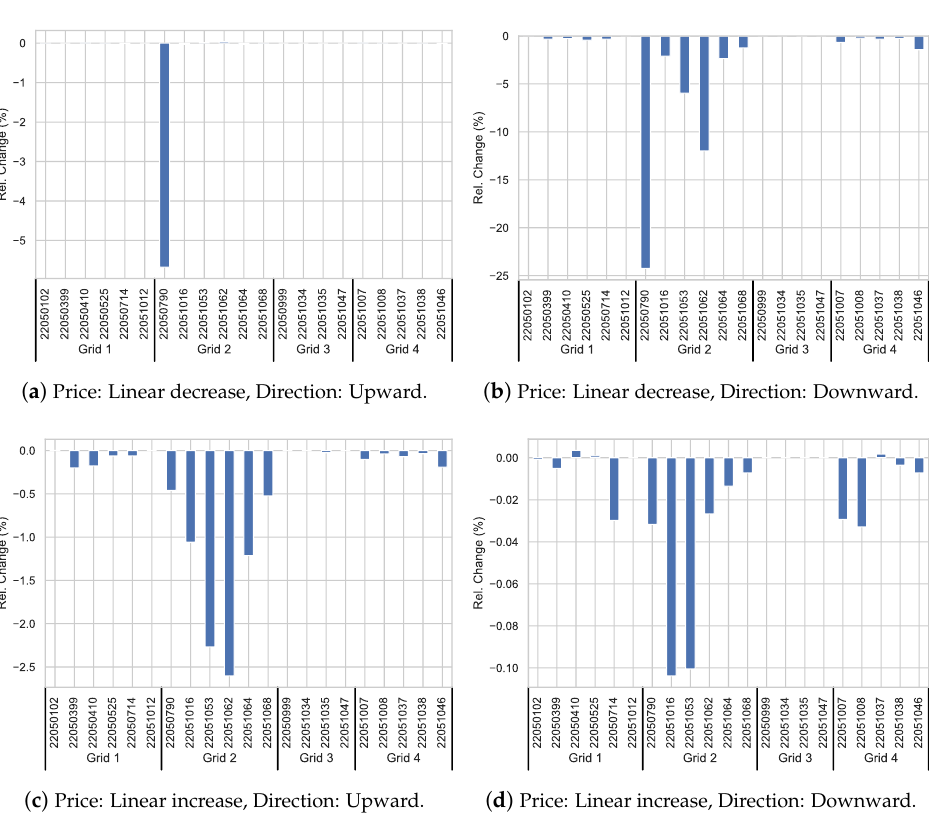
Figure 15. Comparison of the baseline results (all flexibilities have the same price) to the scenarios “linear price decrease” and “increase in the